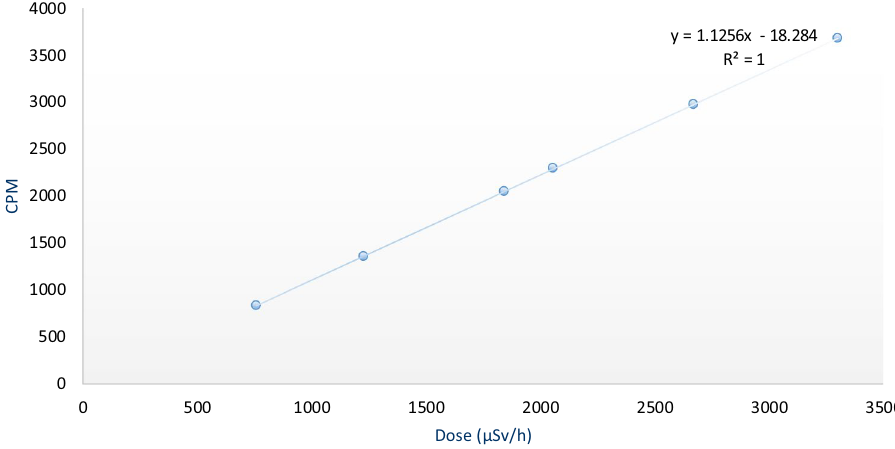
Figure 9. Count per minute versus dose rate (µSv/h), as recorded by the RadioactivityCounter